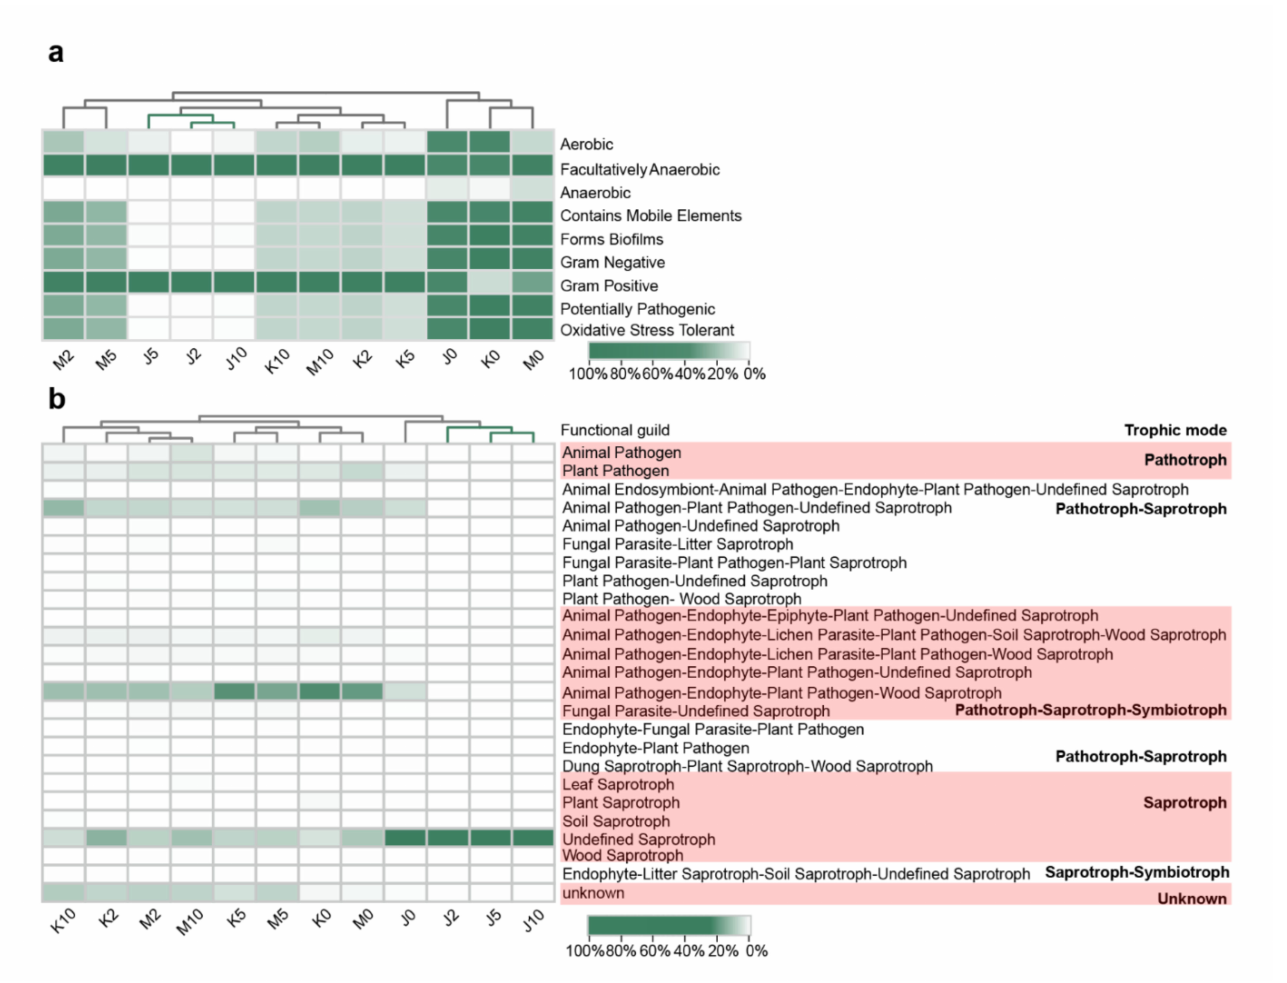
Figure 4. Heat maps showing the dynamics of microflora characteristics of the samples with different additives in the fermented feed. ( a ) The bacterial community phenotypes based on BugBase. ( b ) Fungal community trophic mode and functional guild based on FUNGuild. Only the top 25 guilds are shown in the heat map. The numbers following the J/K/M indicate the sampling time (day) of